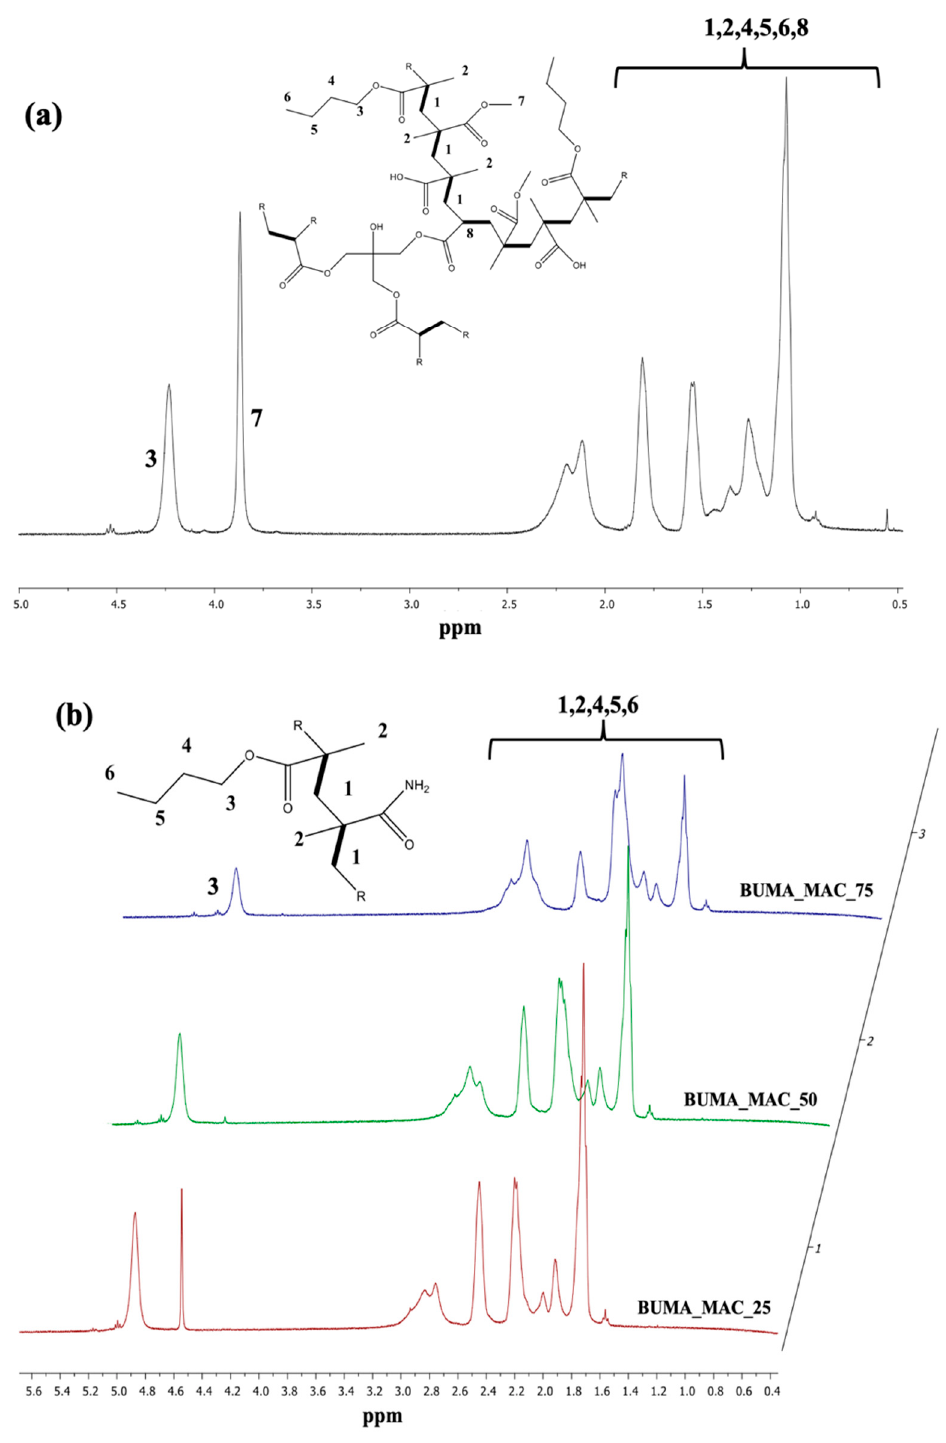
Figure 2. Nuclear magnetic resonance ( 1 H NMR) spectra of ( a ) BUMA_MA_MMA_T3 and ( b ) BUMA_MAC copolymers.